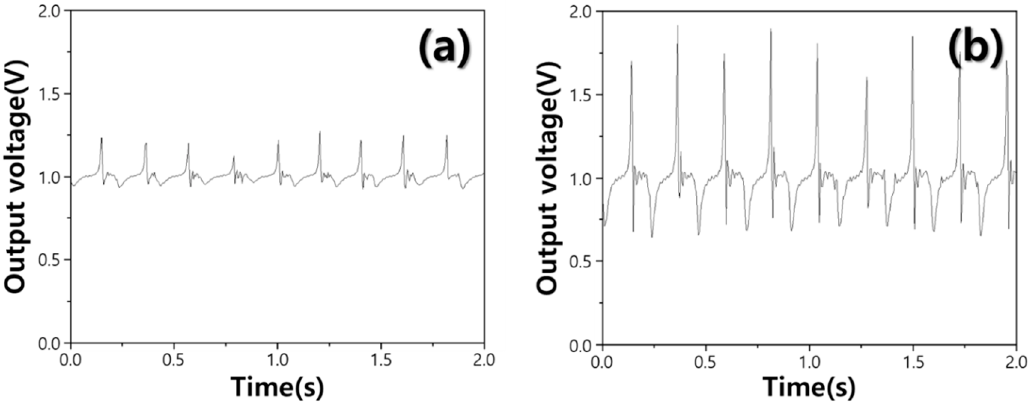
Figure 5. Open-circuit voltage of with PVDF/BCTZC0.25(5.0 wt%) fiber generator ( a ) non-poling and ( b ) 2 kV poling.